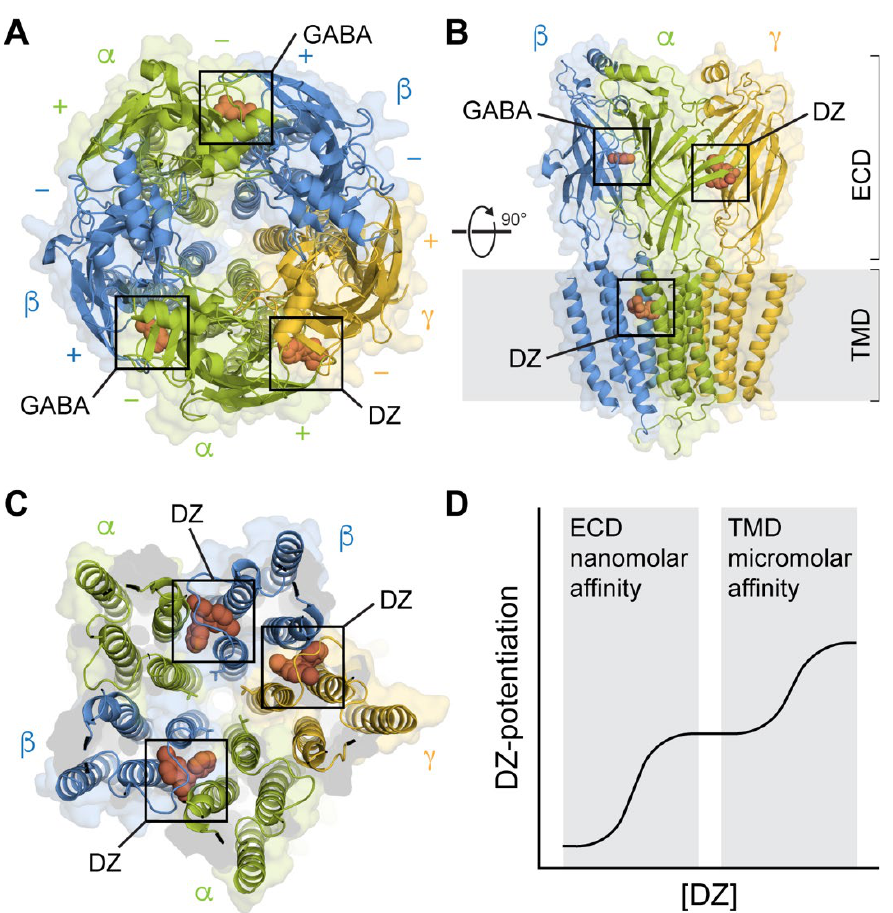
Figure 1. Structures of synaptic GABA A Rs in complex with the BZD PAM diazepam (DZ) at both high-affinity ECD and lower-affinity TMD sites. ( A ) Top-down view with GABA bound at the β +/ α − interfaces and DZ bound at the α +/ γ − interface in the ECD. Cryo-EM map of GABA A (α1) 2 ( β3 ) 2 (γ2) 1 from PDB 6HUP. ( B ) Side view of the structure in A, additionally showing one of several binding sites for DZ in the TMD. Only three subunits are shown for clarity. ( C ) Same perspective as in (A) for a slice through the TMD. Cryo-EM map of GABA A (α1) 2 ( β2 ) 2 (γ2) 1 from PDB 6X3X. Three binding sites for DZ are highlighted at the β +/ α − and γ +/ β − intersubunit pockets between the TM helices and below the M2-M3 linker of one of the subunits. The central pore-gate-forming 9 ′ leucine residues are shown as sticks near the middle of the pore-lining M2 helices. ( D ) Biphasic modulation by DZ at the canonical high-affinity site in the ECD and lower-affinity sites in the TMD.